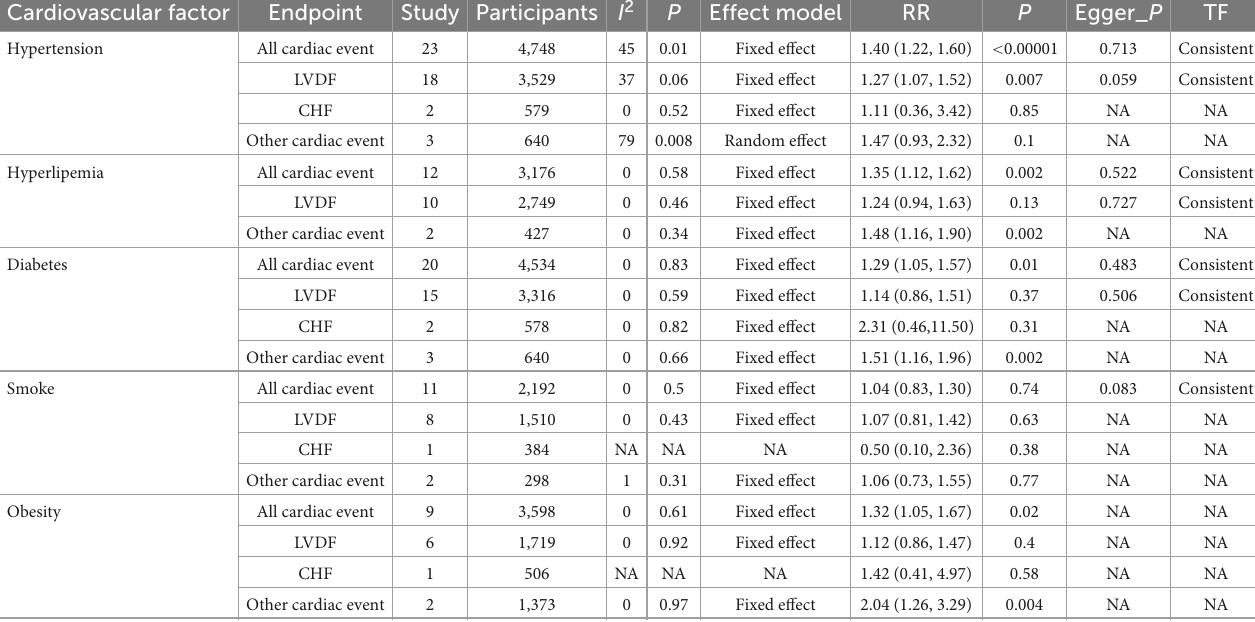
TABLE 1 Risk ratio of cardiovascular risk factor for anthracycline-induced cardiotoxicity. Cardiovascular factor